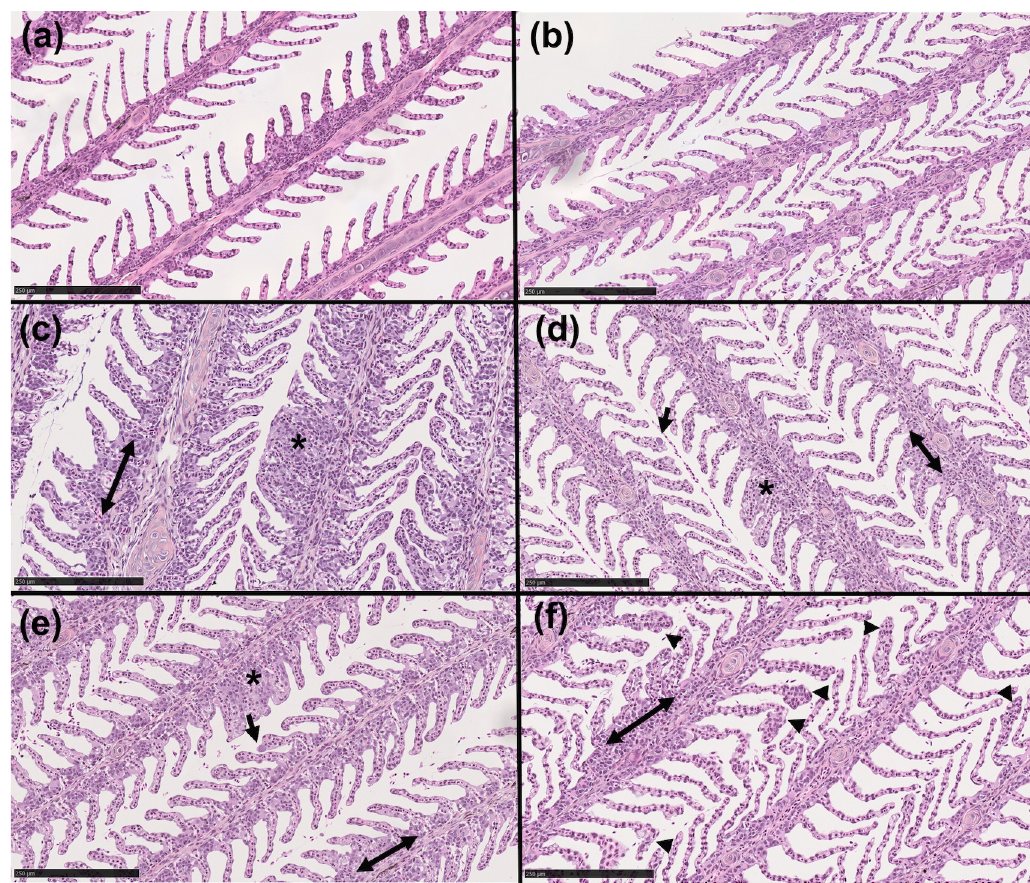
Fig 7. Histological examination of the gills of triploid and diploid Atlantic salmon. (A, B) Hematoxylin & eosin (H&E) stain of diploid and triploid day 0 control gill. (C, D) H&E stain of diploid and triploid day 21 control gill. (E, F) H&E stain of diploid and triploid day 21 SAV infected salmon gill. Arrows indicate epitheliocystis; arrowheads indicate thickening of secondary lamellae tips; double arrows indicate enlargement of basal region of lamellae; asterisks indicate fusion of secondary lamellae. Images are representative of N = 3/group. Scale bar: 250 μ